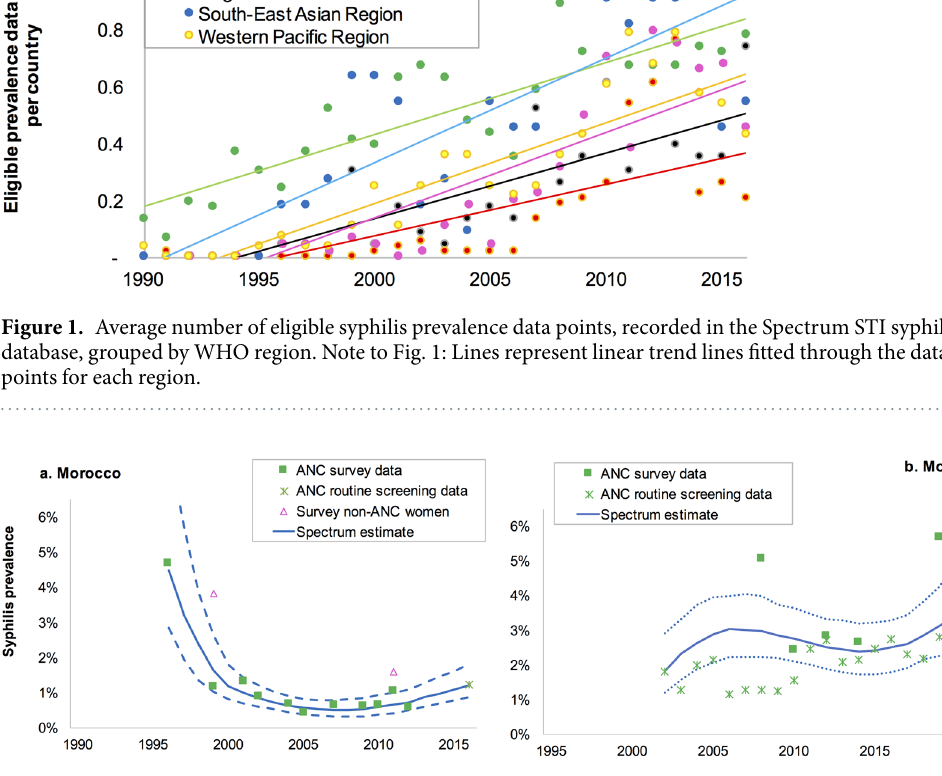
Figure 2. Spectrum-STI estimations of adult female syphilis prevalence ( a ) Morocco and ( b ) Mongolia. Notes to Fig. 2: Data shown are after adjustment for diagnostic test performance. Neither country had any data included from years 1990–1995; both estimations used data from ANC and general populations only; both countries were classified as having a non-substantive prevalence increase over 2012–2016. Solid line = is the best estimate (median of 400 bootstraps), dashed lines are the 95% confidence interval.